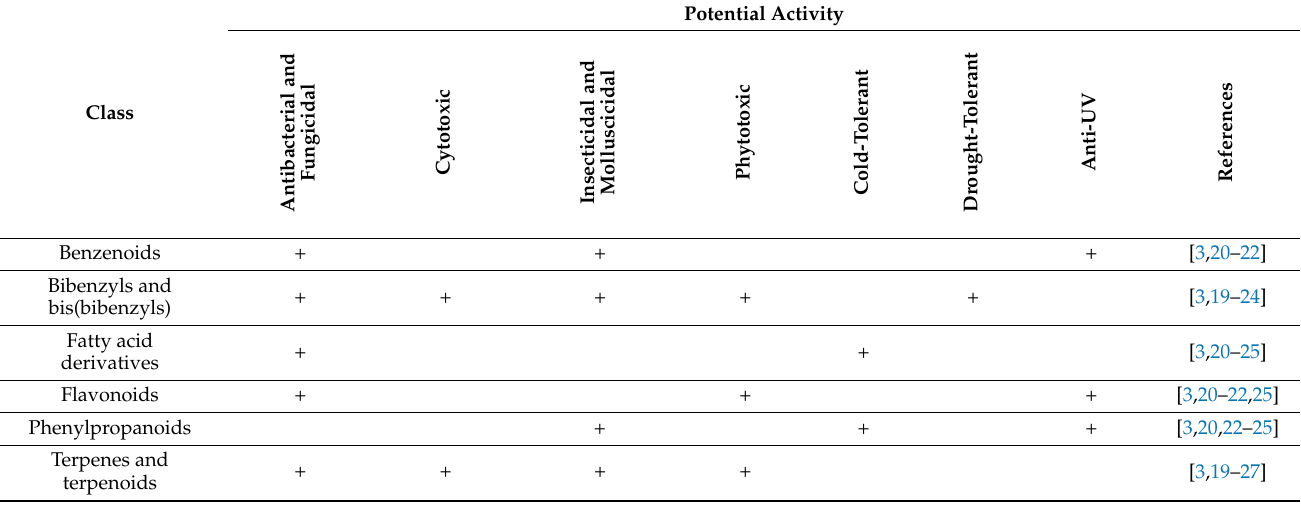
Table 1. The main classes of secondary metabolites among bryophytes and their potential